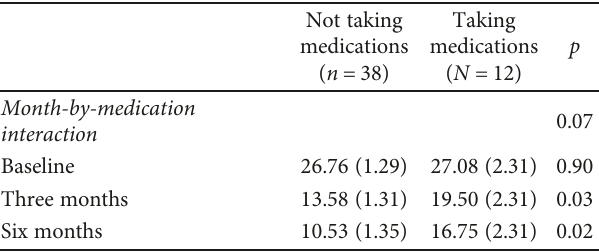
Table 4: Di ff erential response to vitamin D